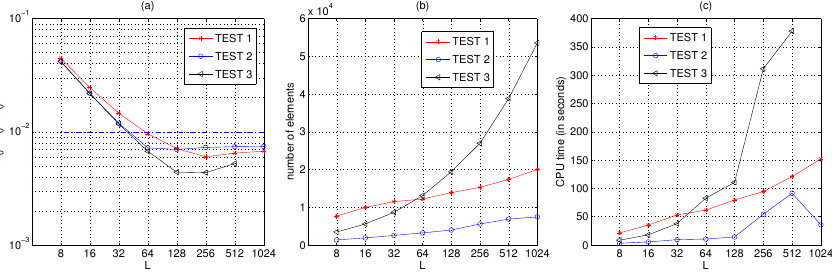
Figure 8. Three tests on prismatic Mesh2 for 10 × 10 contact grid. (a) Relative error at the origin for different domain sizes L . The dashed line indicates the target accuracy defined by Eq. (3.1). (b) Numbers of elements. (c) CPU time in